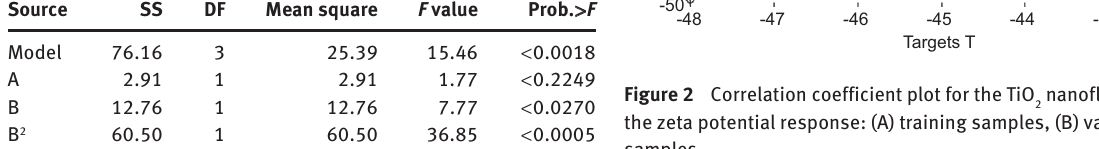
Figure 2 Correlation coefficient plot for the TiO the zeta potential response: (A) training samples, (B) validation